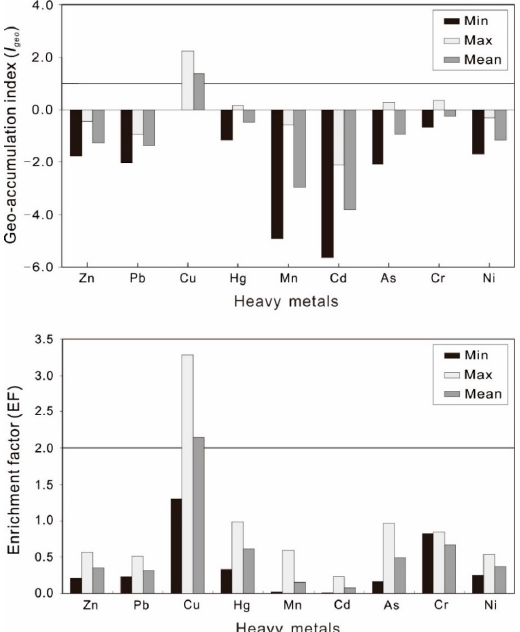
Figure 2. Maximum, minimum, and average values of geo-accumulation index and enrichment